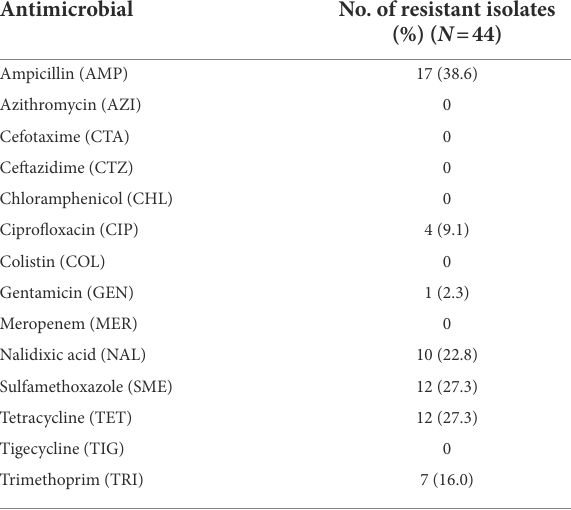
TABLE 3 Antimicrobial resistance of E . coli isolated from broiler carcasses condemned with cellulitis, scratches, and hepatitis.